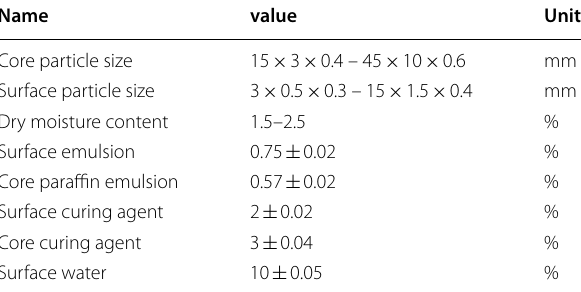
Table 1 Production parameter information before sizing